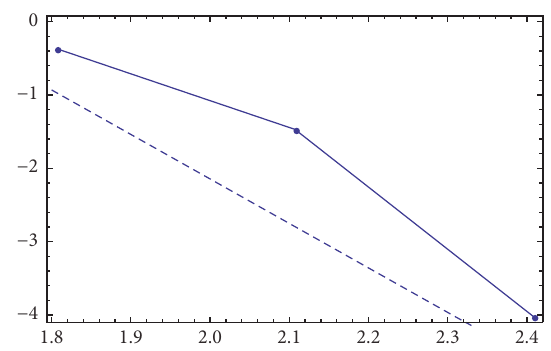
Figure 1: Plot of the decimal logarithm of the maximum error against log 10 𝑁 . The time step is fixed at Δ𝑡 = 1𝑒 − 5 . We see that the plot is approximately a line with slope −6.07 .